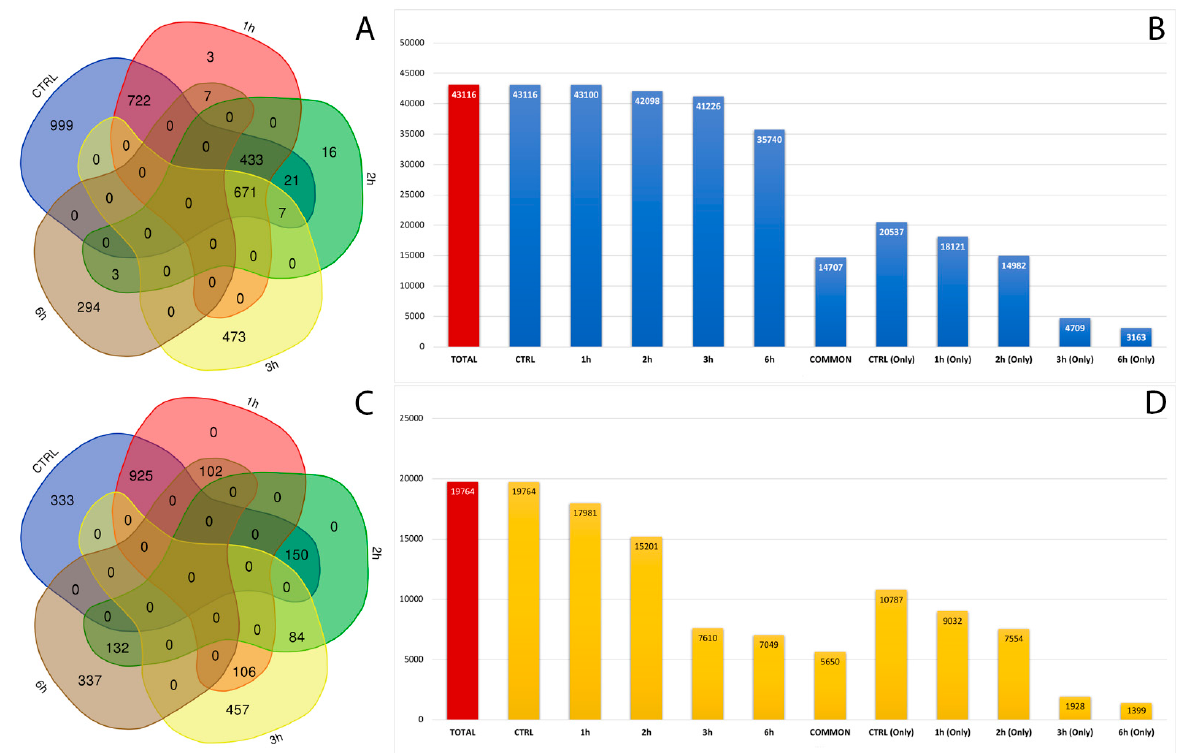
Figure 3. Number of genes and editing sites during treatment stages. ( A ) Number of unique or com- mon genes with already known editing sites in RPE samples at considered time points. ( B ) Number of known editing sites in RPE samples at considered time points. ( C ) Number of unique or common genes with de novo editing sites in RPE samples at considered time points. ( D ) Number of de novo editing sites in RPE samples at considered time